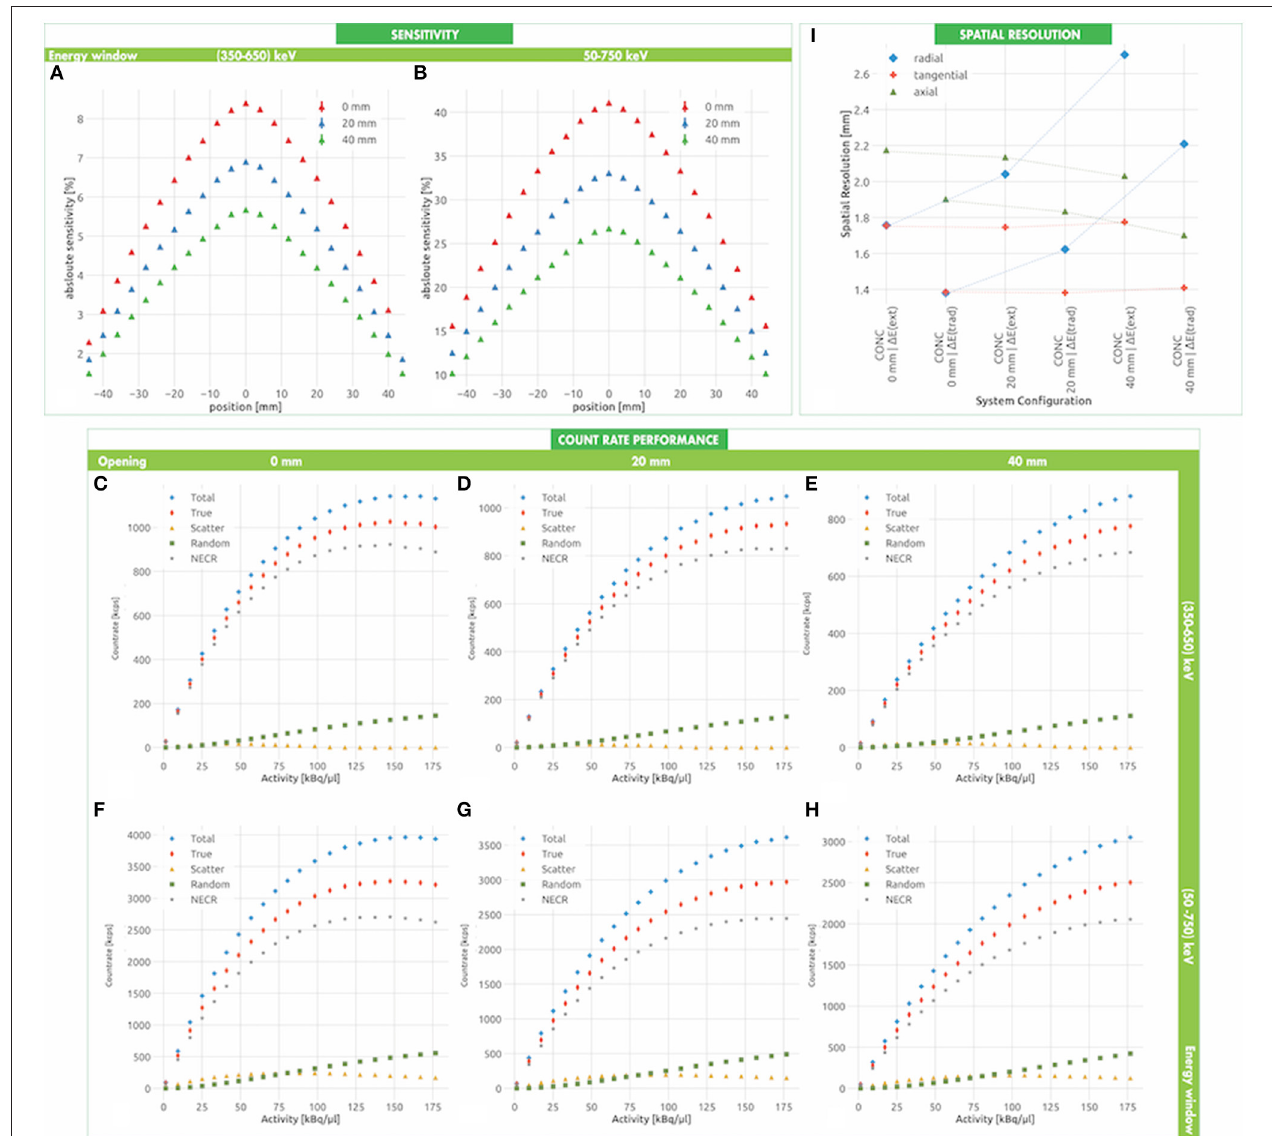
FIGURE 4 | Conceptual system expected performances. The sensitivity is estimated for the conventional (A) and the enlarged (B) energy window at three openings of the two half-cylinders. Similarly, the count rate figure is estimated at three openings of the two half-cylinders for the conventional (C–E) and enlarged (F–H) energy window, respectively (see also Supplementary Tables 2, 3 ). The radial, tangential and longitudinal spatial resolution at the center of the FOV are reported in (I) for different energy windows and opening angles (see also Supplementary Tables 4–7 ). The dashed lines represent the spatial resolution profiles related to the same energetic window over different